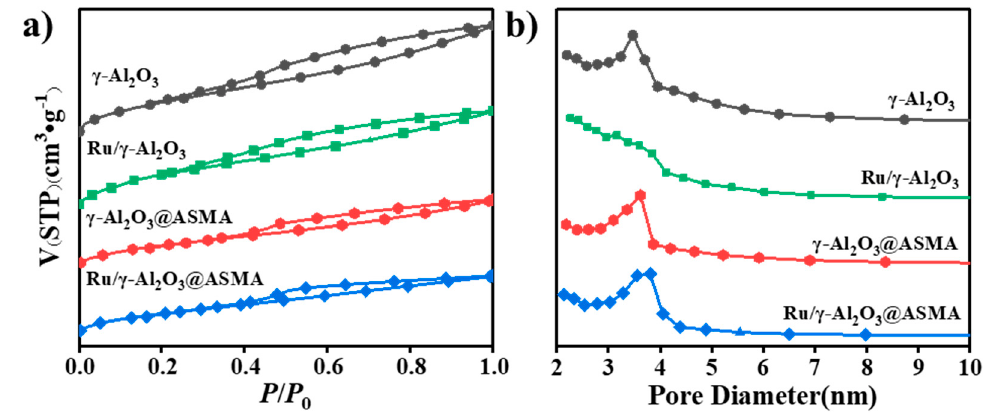
Figure 1. XRD pattens of ( a ) γ -Al 2 O 3 , ( b ) γ -Al 2 O 3 @ASMA, ( c ) 5%Ru / γ -Al 2 O 3 @ASMA, and ( d ) 5%Ru / γ -Al 2 O 3 .